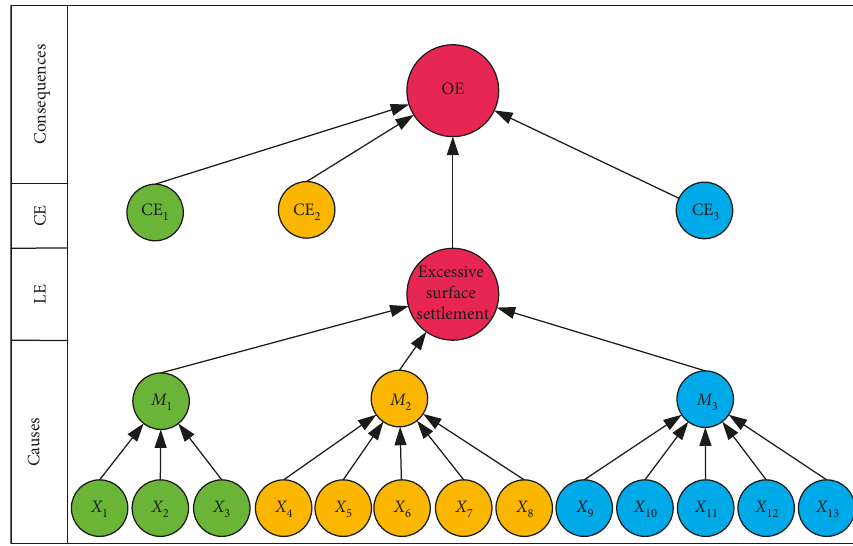
Figure 10: Bow-tie chart of excessive surface Table 11: Probability of equipment fault.